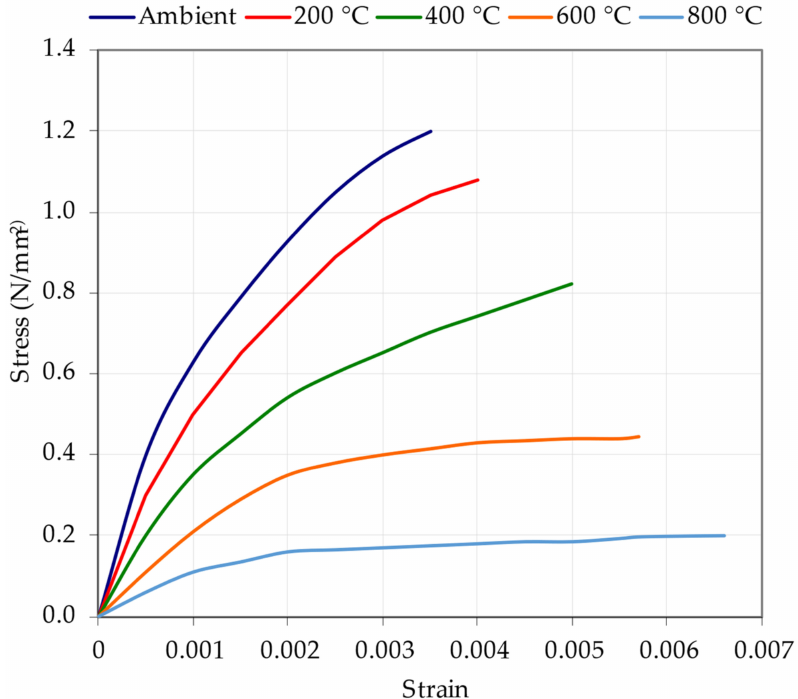
Figure 10. Stress–strain relationship for 500 kg/m 3 density at varying temperatures.